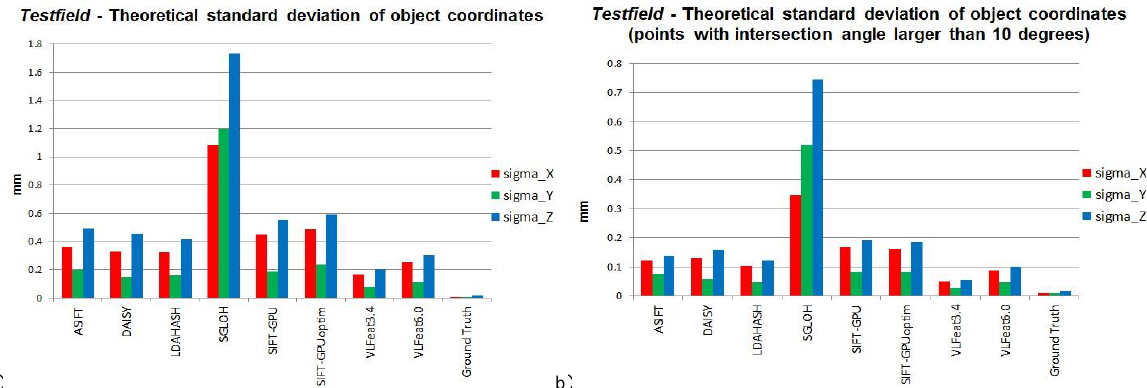
b) Figure 8: Derived theoretical precision of the computed object coordinates for the Testfield dataset: statistics for all 3D points (a) and for the 3D points with an intersection angle larger than 10 degrees (b). The SGLOH method has low accuracy results as the used implementation can